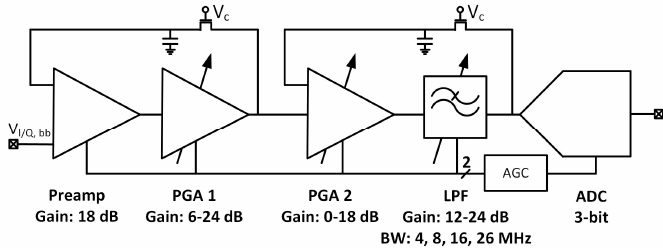
Figure 15. Block diagram of dual-frequency analog IF and ADC.